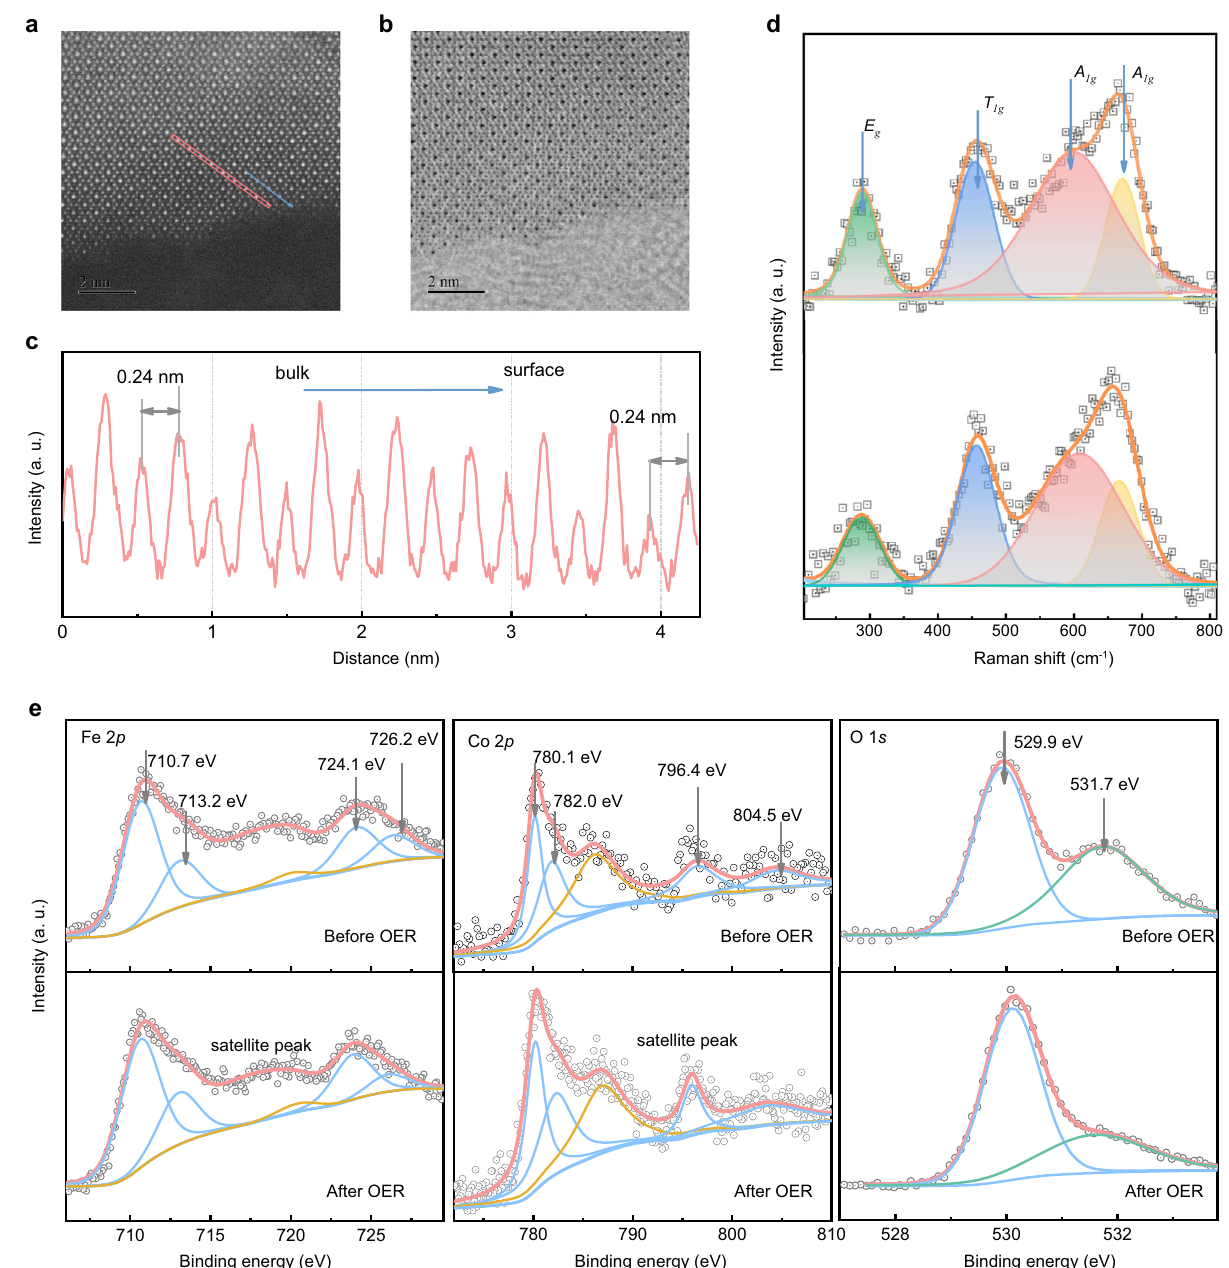
Fig. 2 No surface restructuration on CoFe 2 O 4 . HADDF ( a ) and ABF ( b ) images of CoFe 2 O 4 after OER. The line pro fi les of HADDF ( c ) acquired at the pink line rectangular zone. d Raman spectra of CoFe 2 O 4 before and after OER. e The Fe 2 p , Co 2 p , and O 1 s XPS spectra results of CoFe 2 O 4 before and after